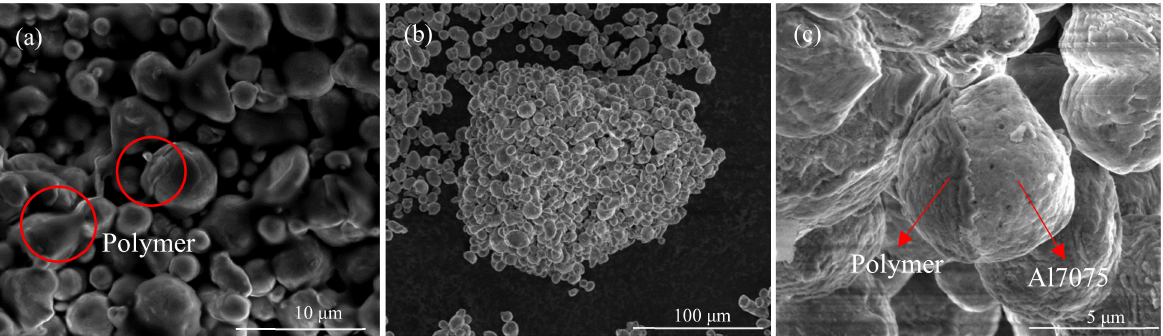
Figure 4. SEM images showing the morphology of the powder/binder mixture. ( a ) Commercial 17-4 steel filament. ( b , c ) Wet-mixing processed Al7075 powder with the polymer